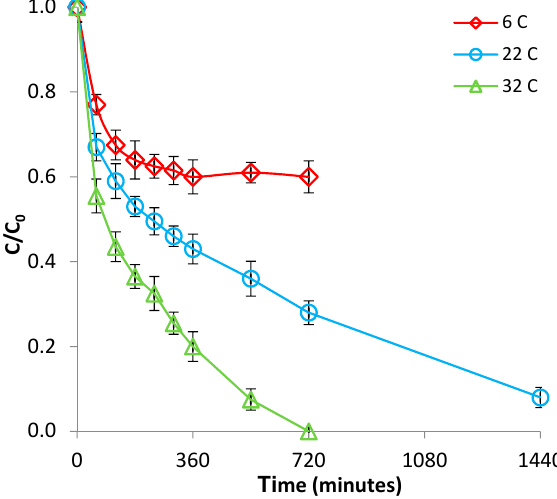
Figure 7. Effect of temperature on Cr(VI) removal by Be-Fe(0).